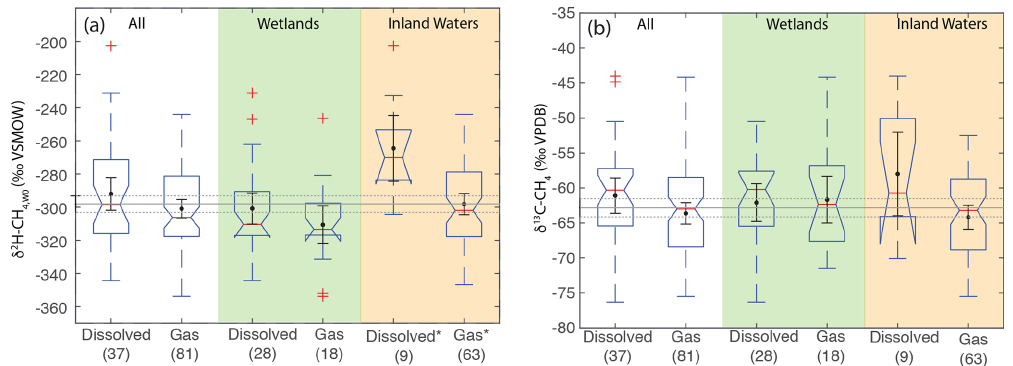
Figure 9. Boxplots of (a) δ 2 H–CH 4 ,W 0 and (b) δ 13 C-CH 4 for sites differentiated by sample type. Numbers in parentheses indicate the number of sites for each category. Boxplot parameters are as in Fig. 7. Black points and error bars indicate the category mean and 95% confidence interval of the mean. Grey lines indicate the mean values across all categories, and the dashed lines indicate the 95% confidence interval of this value. Two extremely low outliers ( < − 80‰; dissolved wetland and gas inland water) are not shown in (b) . Asterisks in (a) indicate that dissolved and gas-phase CH 4 samples from inland water sites have significantly different distributions.